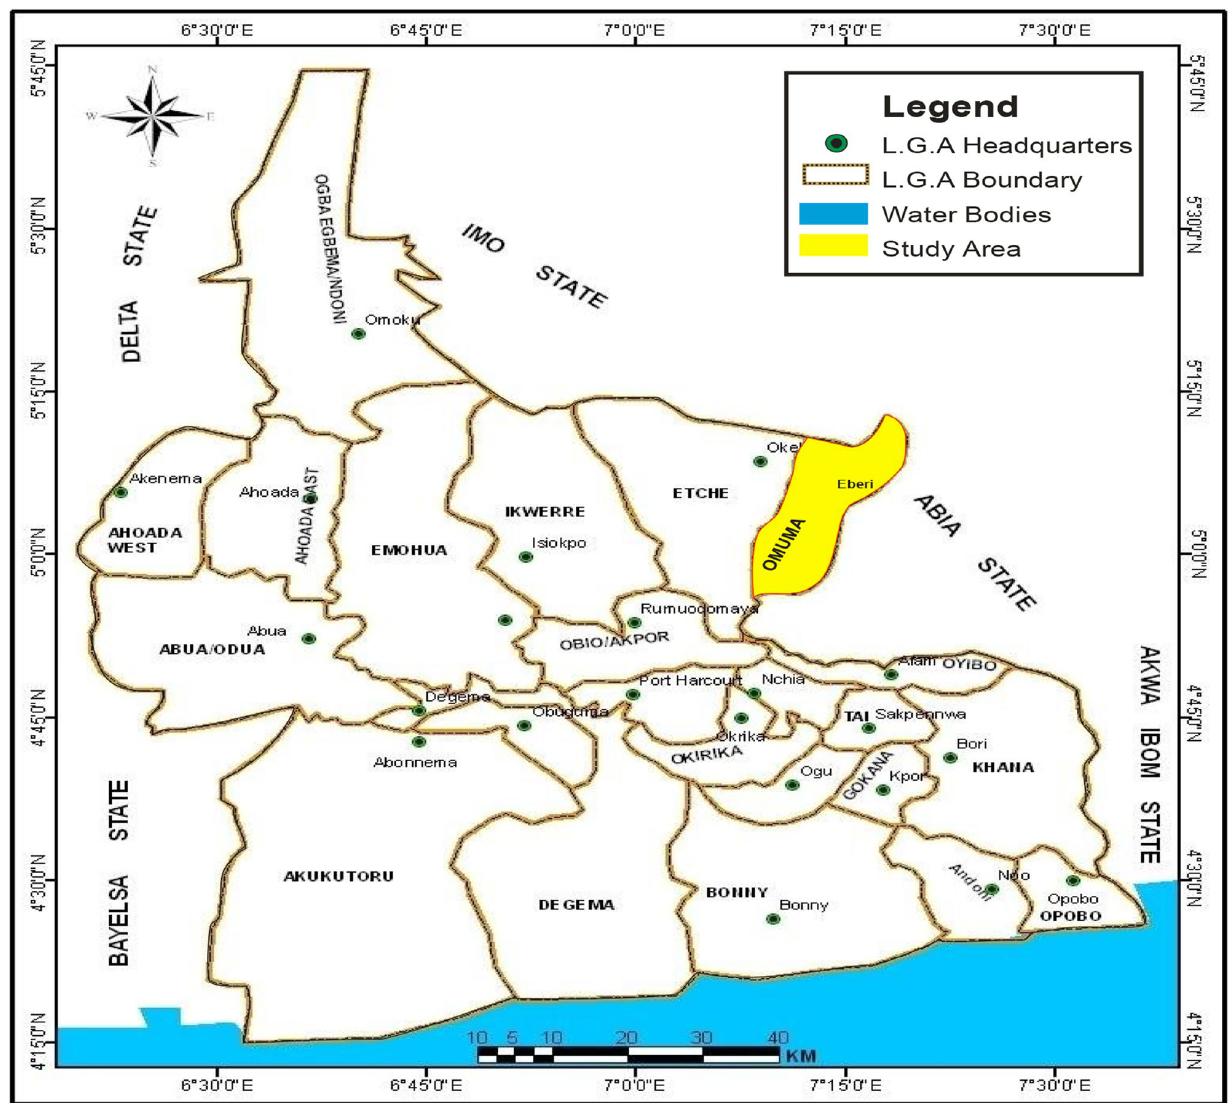
Fig. 1 Map of Rivers State showing the study